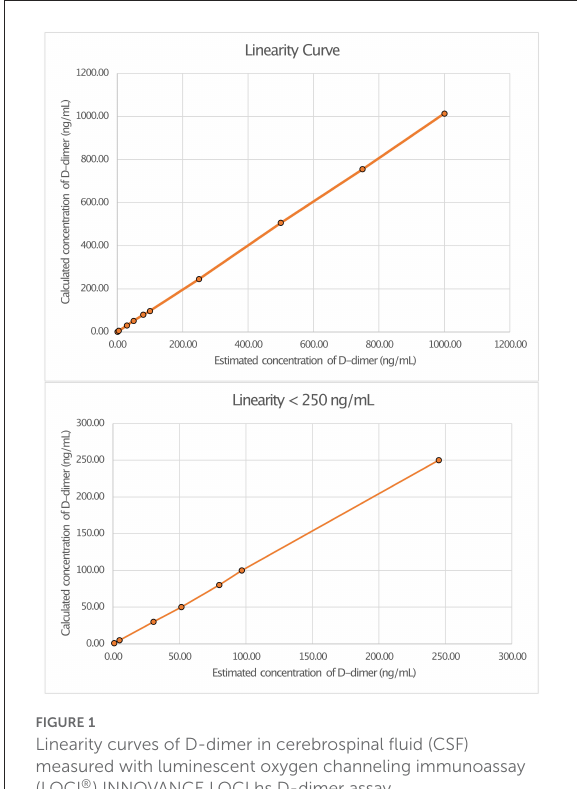
FIGURE2 Calibration curve of D-dimer measurement in